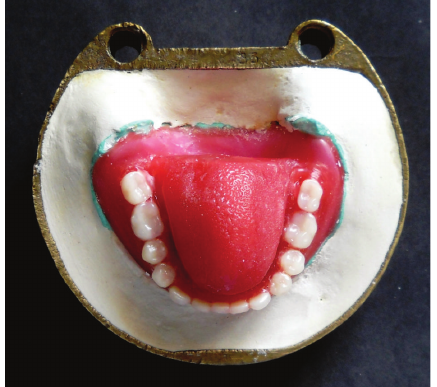
Figure 6: Flasking of the tongue